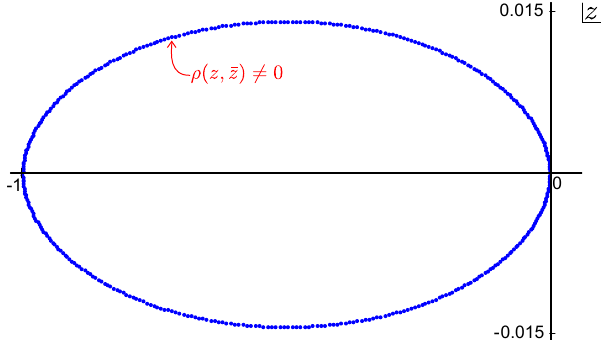
Figure 4 . Distribution of zeros for (4.23) for k = 3